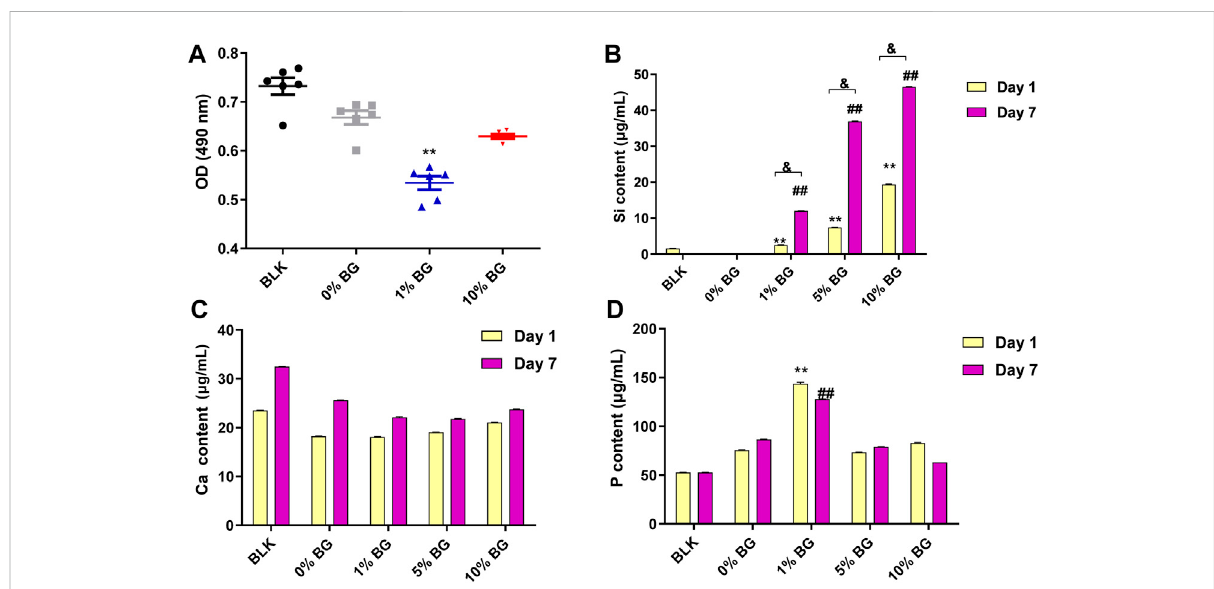
FIGURE 8 CellviabilityofHPDLCsbyusingMTSassayandtheionreleaseofthebiomimeticBG/GelMAscaffoldsbyICP-MS (A) TheOD(490 nm)valuesin the BLK (Blank: fl at plate)group and the scaffolds0% BG, 1% BG, and 10% BG groups on day 3; The Ca ion release (B) , theSi ion release (C) , and the P